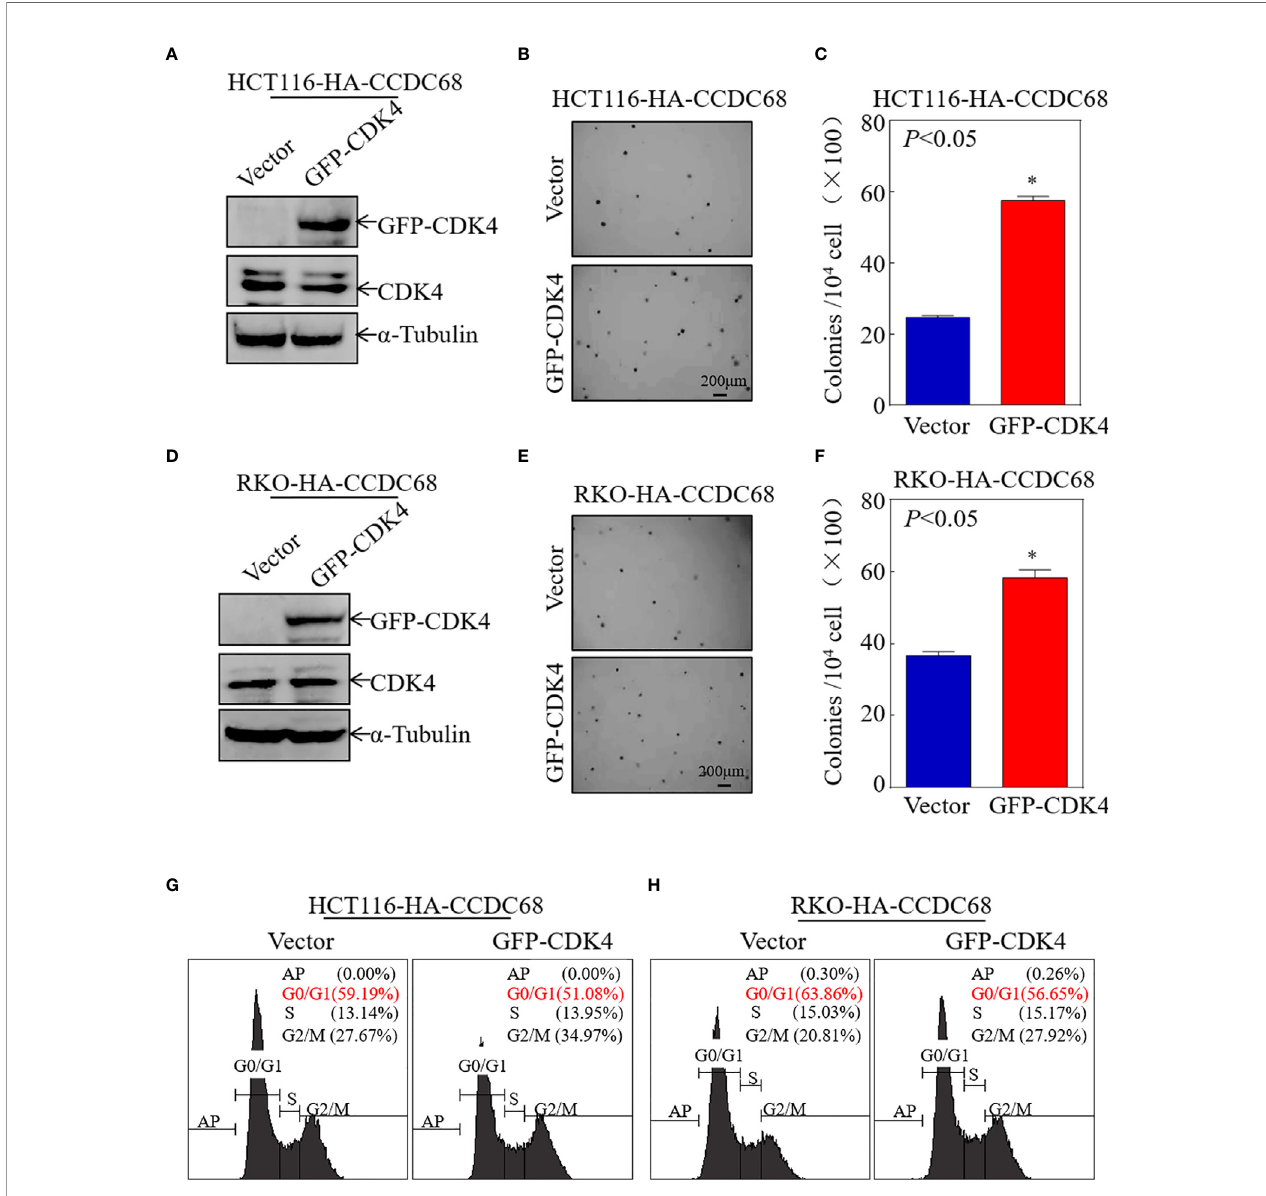
FIGURE 4 | CCDC68 inhibits malignant CRC cell proliferation by downregulating CDK4. (A, D) Stable transformation ef fi cacy was assessed by western blotting in HCT116 (CCDC68) and RKO (CCDC68) cells overexpressing GFP-CDK4. (B, E) A soft agar colony formation assay was used to detect the effect of CDK4 on the proliferation of CRC cells. (C, F) Diagrams comparing the number of cell clones between the control and experimental groups. (G, H) Effect of CDK4 on the G0/G1 phase in HCT116 (CCDC68) and RKO (CCDC68) cells. Data are presented as the mean ± SD and analyzed by Student ′ s t -test, * P <